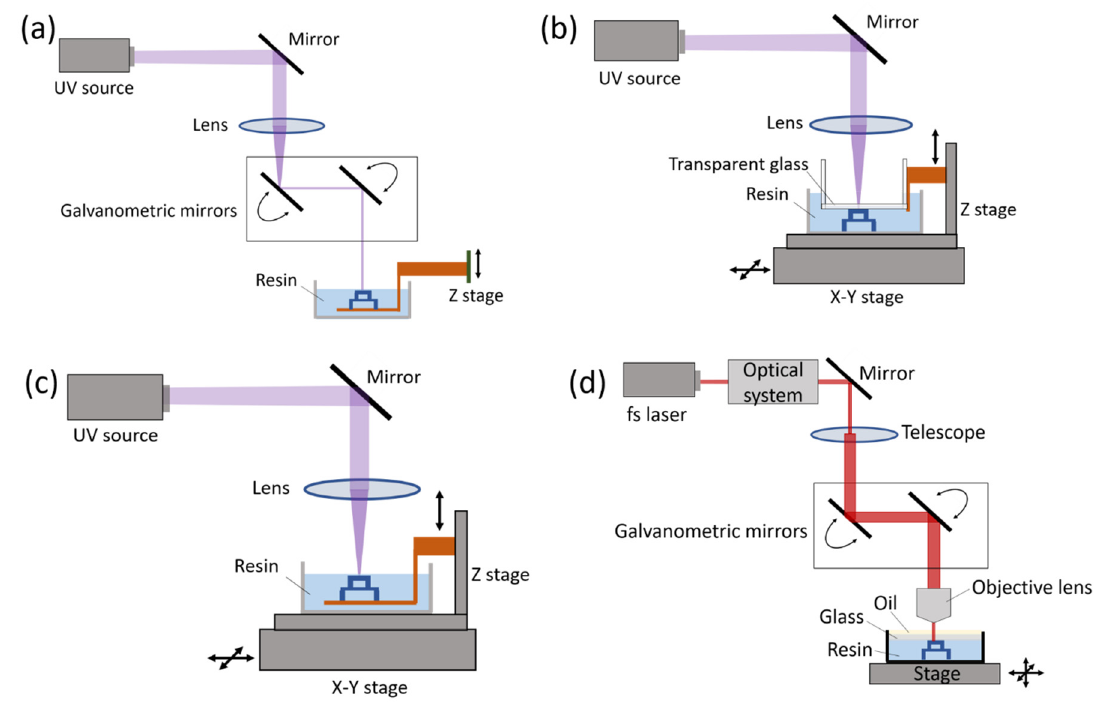
Figure 4. Scanning stereolithography processes. ( a ) Scanning stereolithography with dynamic light beam. ( b ) The constrain-surface system. ( c ) The free-surface system [74]. ( d ) A typical two-photon polymerization (2PP) system.